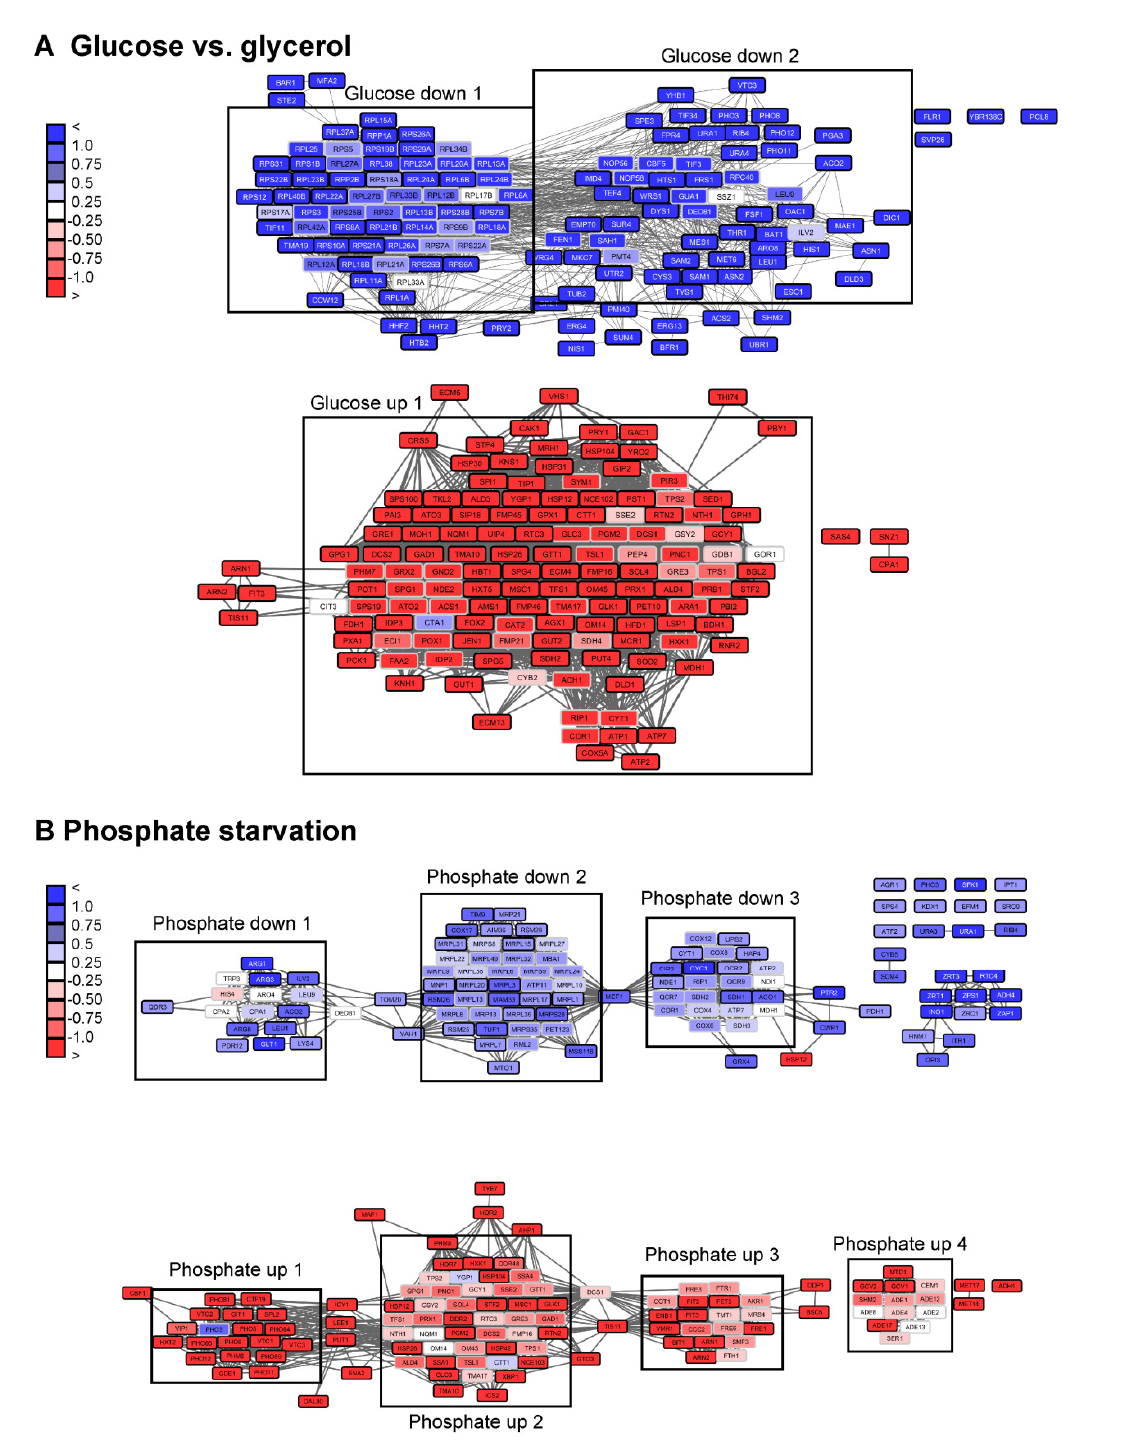
FIGURE 6: Visualization of networks upon glucose-depletion and phosphate starvation. The top 100-hits of different datasets were con- nected in ClusterEx and visualized in Cytoscape. Connectivity is retrieved as described by obtaining 20 coregulators from SPELL and including 50 connectors. The edge-weighted spring embedded layout is used to position highly connected genes in close proximity in Cytoscape. Genes are colored according to their log differences in the respective experiments. Clusters which are further analyzed for their GO-terms via PANTHER and for their transcription factors via the YEASTRACT web service are marked with black boxes. A) Genes differentially regulat- ed in S. cerevisiae upon growth on the carbon sources glucose versus glycerol [37] were built into an interconnected network. The top100 hits (black frame) and 50 connectors (grey frame) were included into the network. Upper panel: downregulation, lower panel: upregulation. B) Genes differentially regulated in S. cerevisiae upon phosphate starvation [27] were built into an interconnected network. The top100 hits (black frame) and 50 connectors (grey frame) were included in the network. Upper panel: downregulation, lower panel: